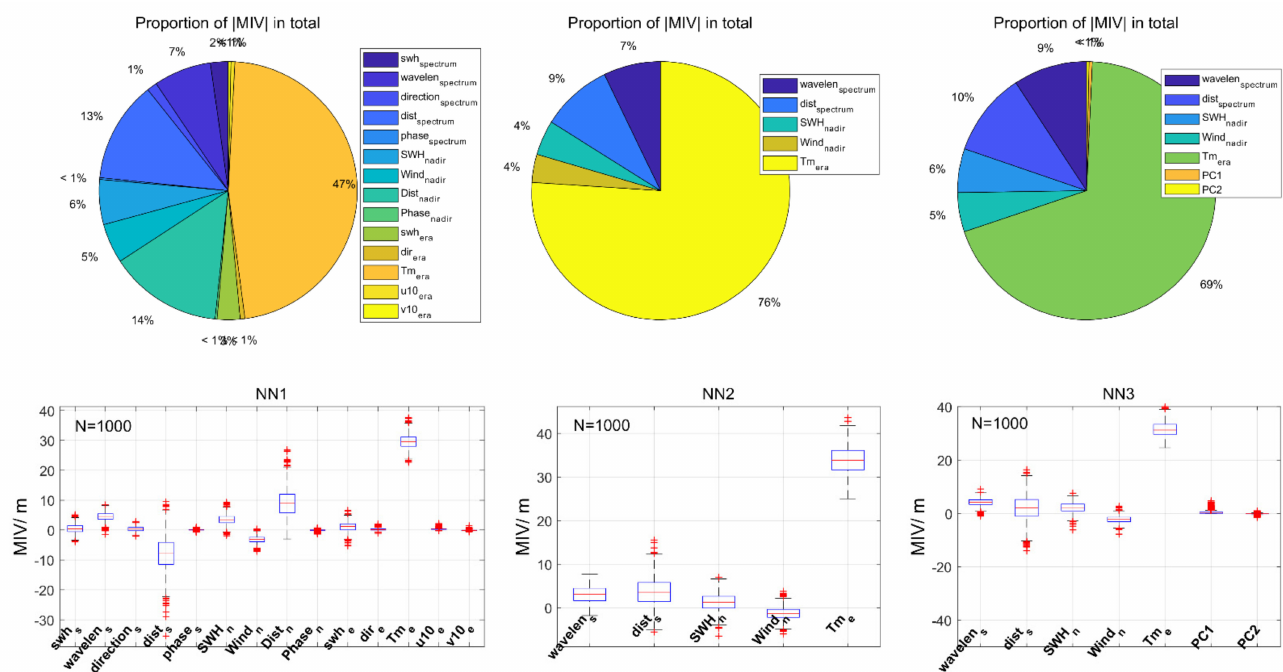
Figure 8. Similar to Figure 6 but for CFOSAT + ERA5 parameters (Tables 1 and 2) are included in the NN modeling. Points in red “+” are drawn as outliers if they are larger than the maximum (Q3 + 1.5 × (Q3 − Q1)) or smaller than the minimum (Q1 − 1.5 × (Q3 − Q1)), where Q1 and Q3 are the 25th and 75th percentiles,